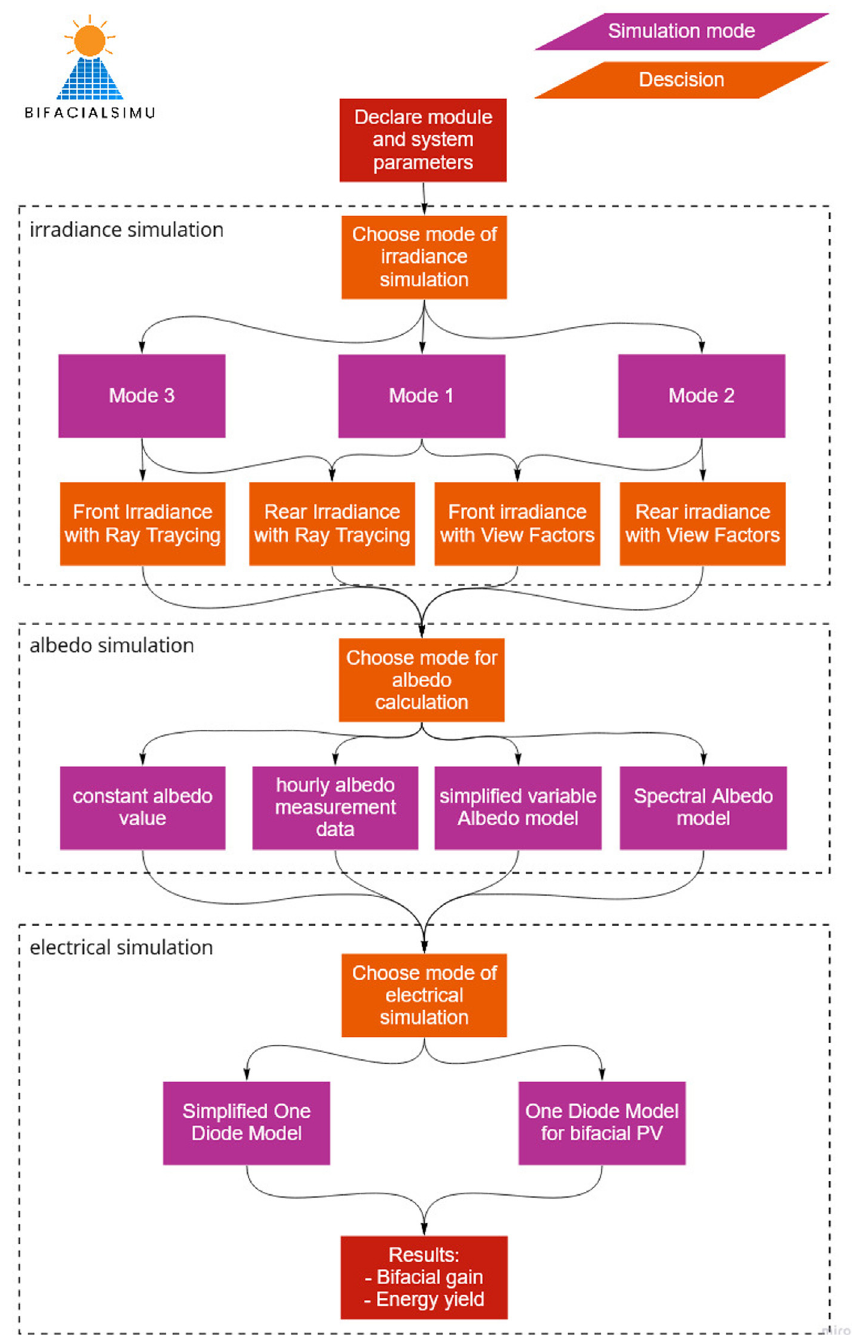
Fig. 1. The simulation procedure can be divided into 3 different parts. The irradiance simulation de fi nes the calculation method for front and rear side of the PV module and uses either VF, RT or both. The albedo simulation can be conducted using a simpli fi ed variable Albedo model or a Spectral Albedo model approach. The user can also de fi ne a constant albedo value or implement albedo measurements into the simulation. Finally, the electrical simulation calculates energy yield and bifacial gain of the PV plant using either a simpli fi ed One Diode model or a One Diode model speci fi cally tailored to bifacial